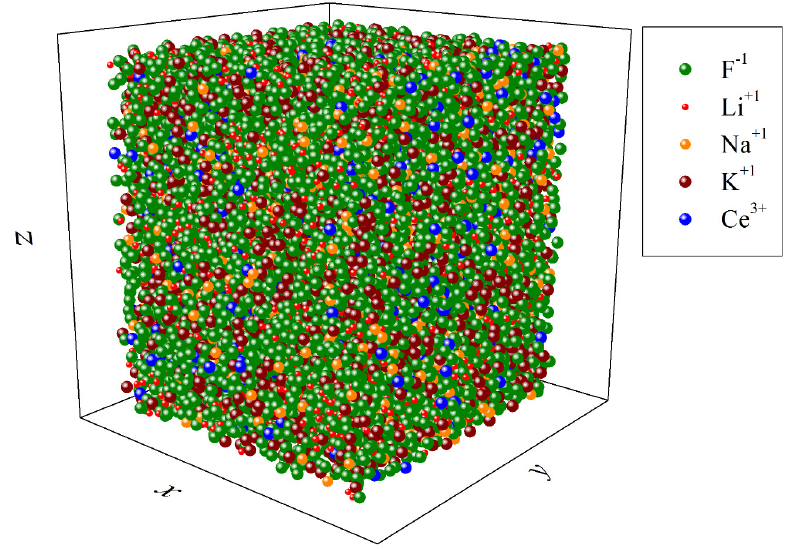
Figure 2. FLiNaK+Ce system configuration corresponding to 200 ps time at 1000 K.